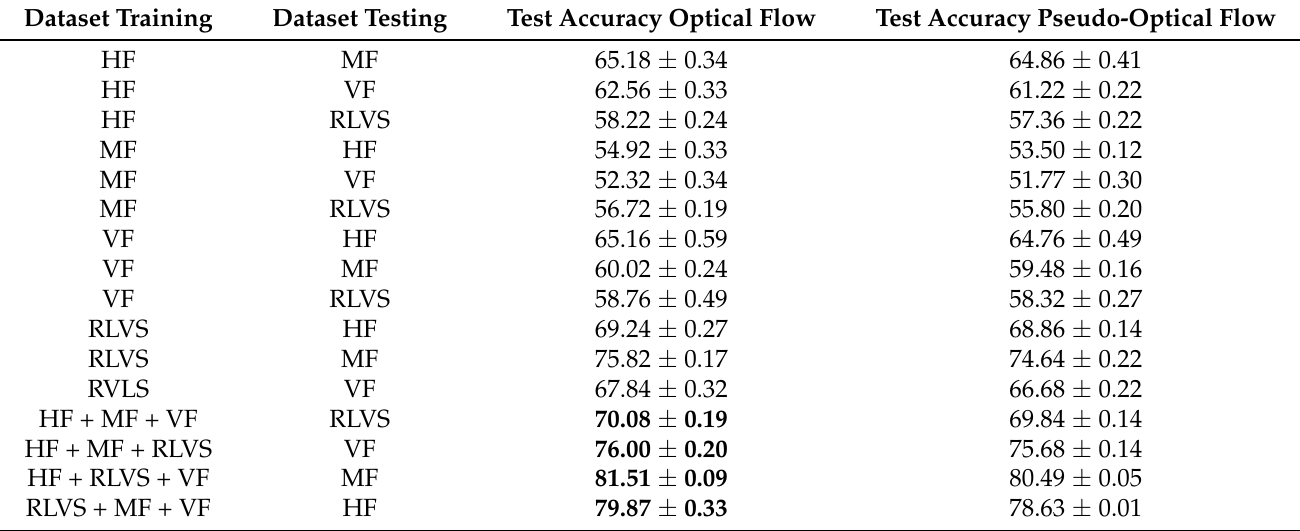
Table 5. Cross-dataset experiment results.